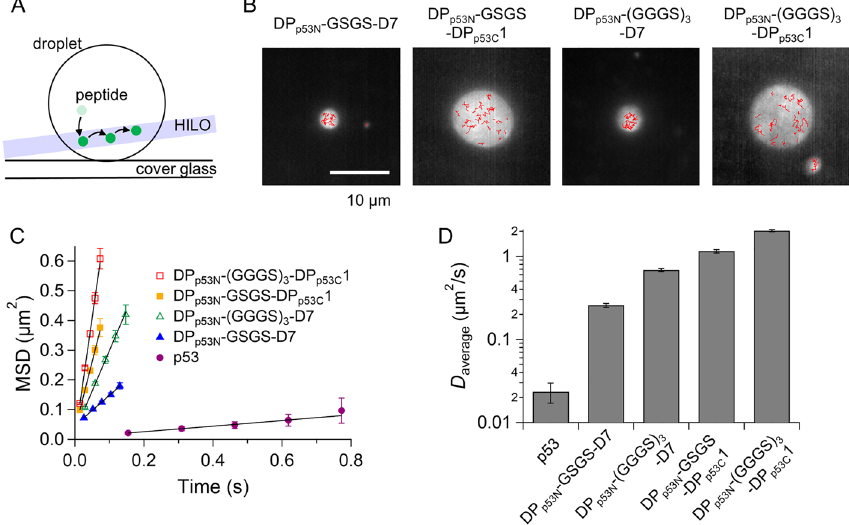
Figure 3. Diffusion dynamics of designed peptide and p53 in their droplets. ( A ) Schematic diagram of single- molecule tracking of fluorescent peptides or p53 in a droplet. HILO illumination minimizes background fluorescence, enabling single-molecule detection of labeled peptides (green) in droplets. ( B ) Typical trajectories of Alexa488-labeled designed peptides in corresponding droplets in 45 mM NaCl and 150 mg/mL dextran at pH 7.0. The typical trajectories of single molecules (red) are overlaid in fluorescent images derived based on time averaging (white droplets). ( C ) Mean square displacement plots of Alexa488-labeled designed peptides or Atto488-labeled p53 in corresponding droplets. The straight lines show the best-fit linear functions for the MSD data. Error bars denote standard errors. ( D ) Comparison of diffusion coefficients of the designed peptides and p53 in corresponding